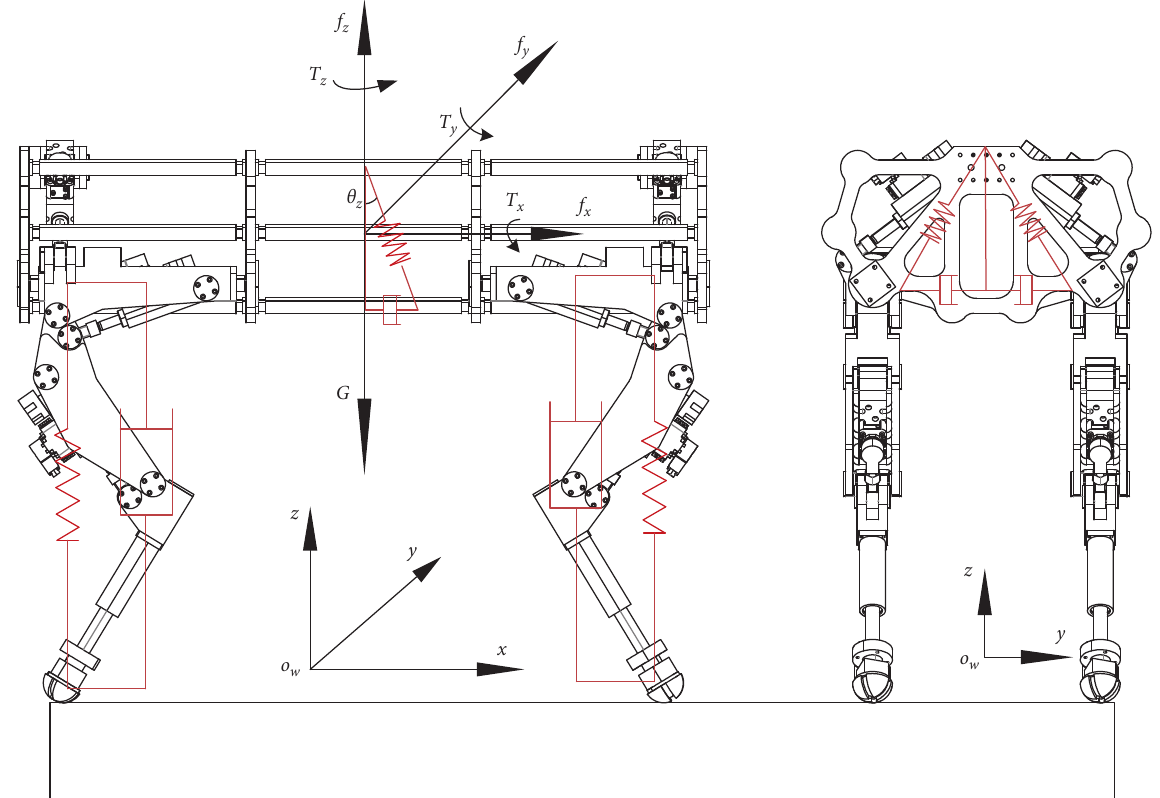
Figure 2: Virtual spring control diagram of